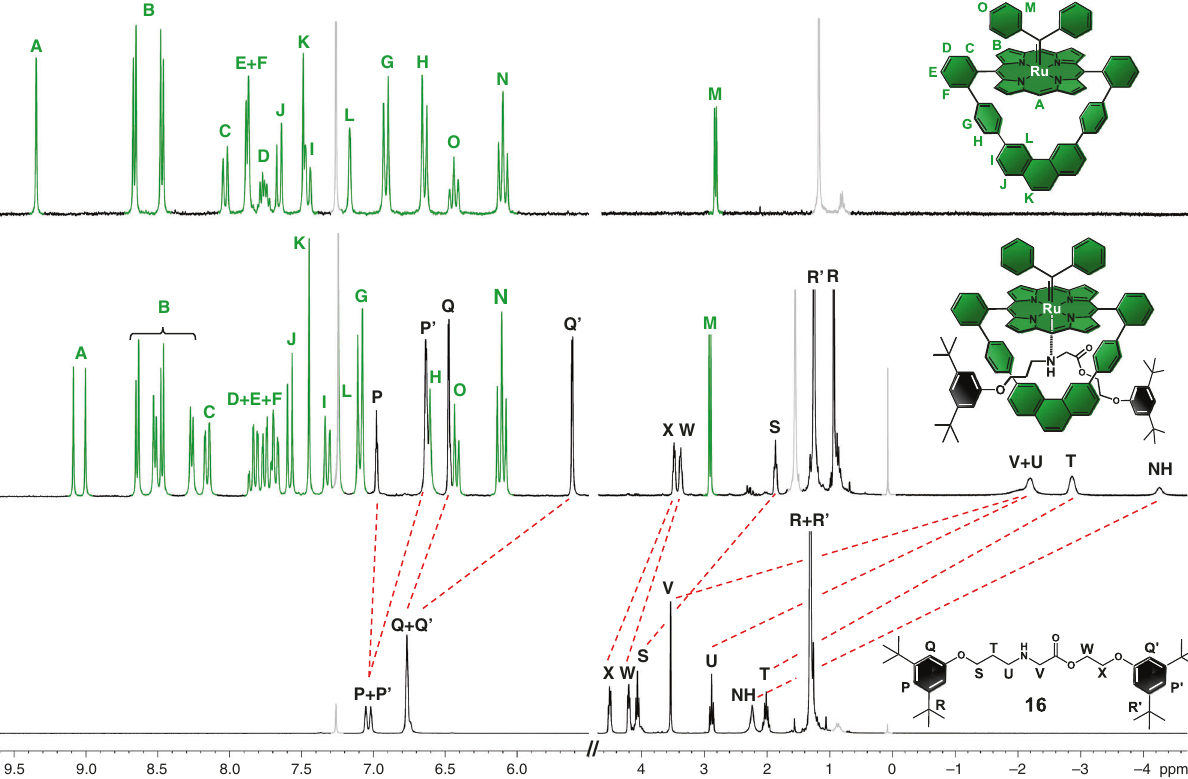
Fig. 5 Selected regions of the 1 H NMR spectra of macrocycle 11 (top), rotaxane 15 (middle) and thread 16 (bottom). Experimental conditions: 250 MHz, CDCl 3 , 298 K. Thread 16 was prepared aside for comparison purposes, using half-threads 13 and 14 as substrates and the acyclic version of 11 as promoter. Unambiguous proton assignments, including the H L signal in rotaxane 15 that overlaps with that of residual chloroform in the deuterated solvent, are based on 2D-NMR spectroscopy. Residual solvent peaks and aliphatic impurities are in gray: chloroform ( δ = 7.26 ppm), water ( δ = 1.56 ppm), “ grease ” ( δ =